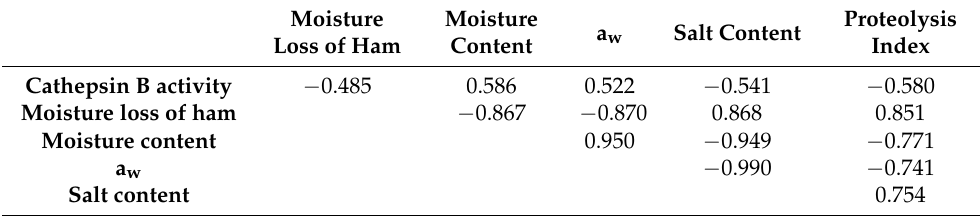
Table 2. Bivariate coefficient of correlation between ham characteristics (measured on biceps femoris if not otherwise specified; no. of hams = 60).